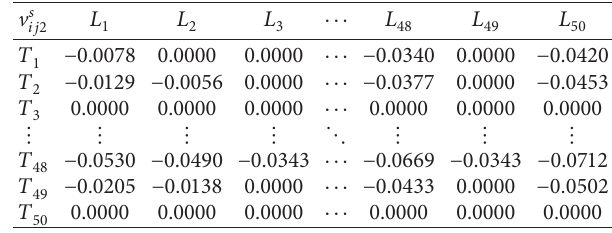
Table 11: Normative profit and loss matrix F landlords’ housing rent.